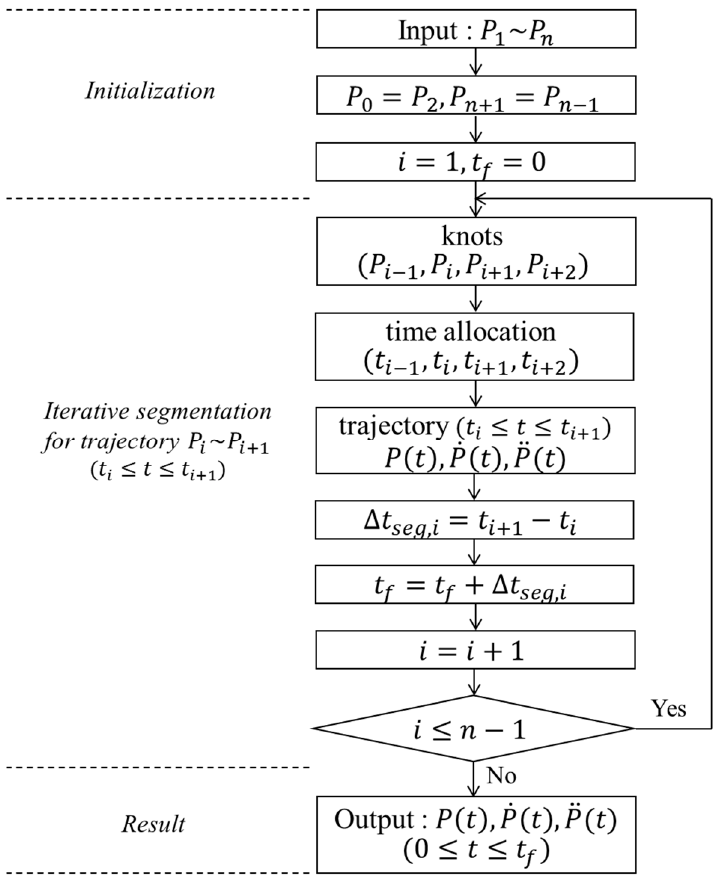
Figure 5. Flowchart of process to plan trajectory for multiple knots from P 1 to P n .